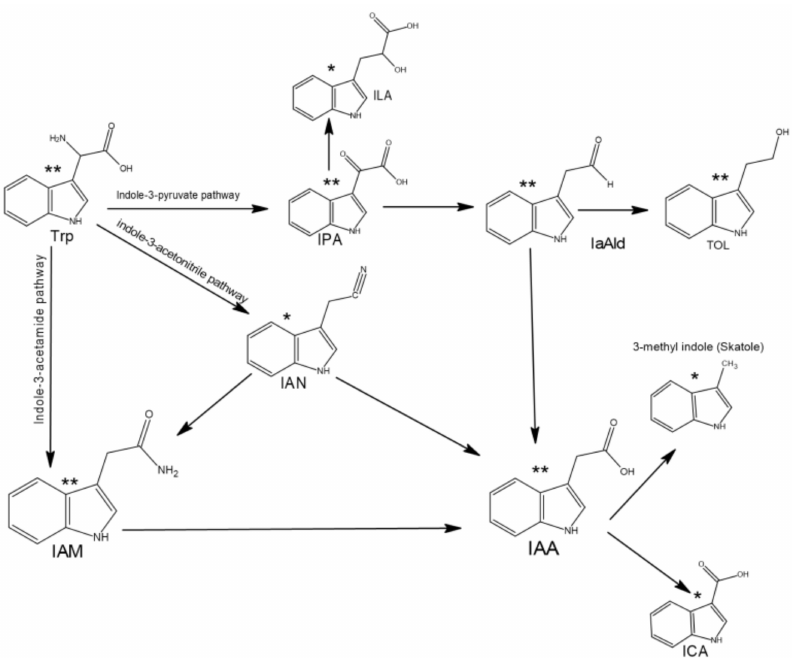
Figure 7. Proposed pathways of indole acetic acid (IAA) synthesis in the supernatant extracts of the Enterobacter sp. cultures, where ** means that the compound was detected in both cultures while * means that it was detected in the extract of Zch127 culture only, where Trp: tryptophan, IAM: indole-3-acetamide, IAN: indole-3-acetamide, IPA: indole-3-pyruvic acid, ILA: indole-3-lactic